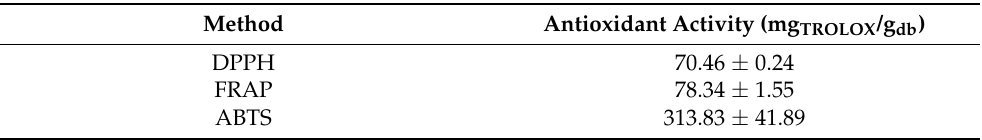
Table 4. Antioxidant activity of grape pomace extracts using DPPH and ABTS methods and its reducing power investigated with FRAP